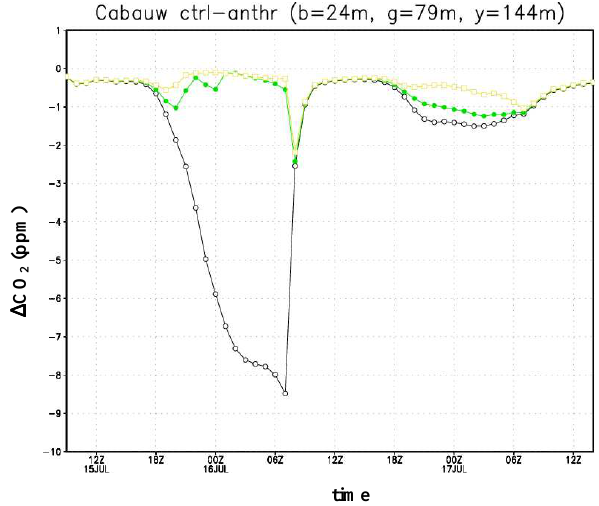
Fig. 16. Difference in simulated [CO 2 ] (ppm) at Cabauw between the control simulation and the simulation with an increase of 20% in anthropogenic emissions for three heights: Black: 24m, green: 79m, yellow: 144m